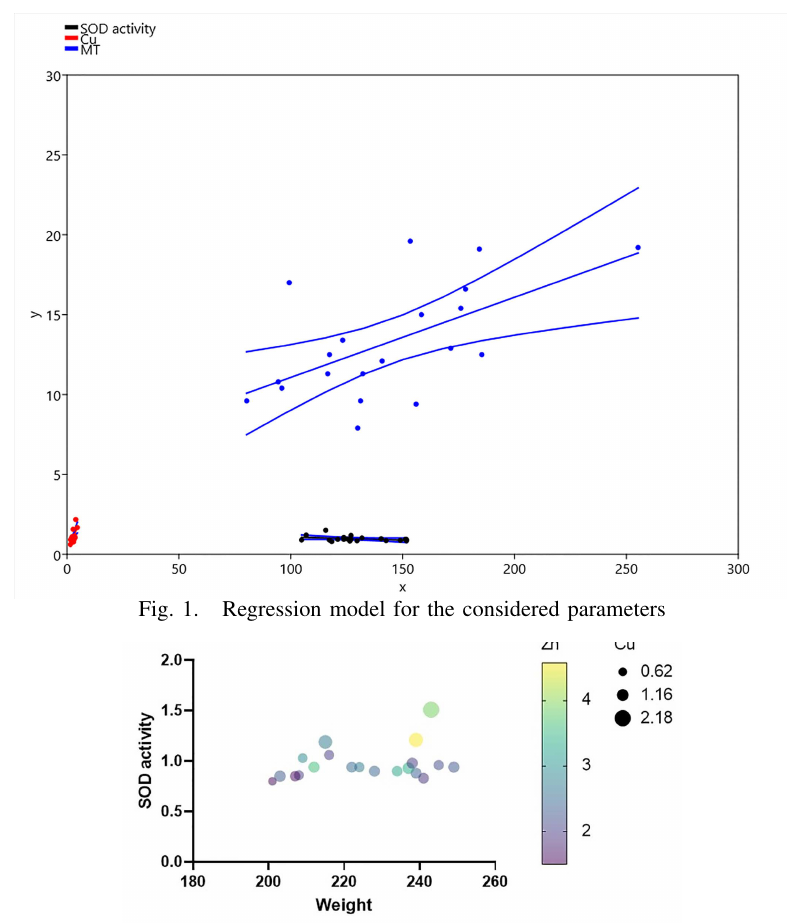
Fig. 2. Linear regression between SOD activity and Weight of the animals, considering zinc and copper concentrations in